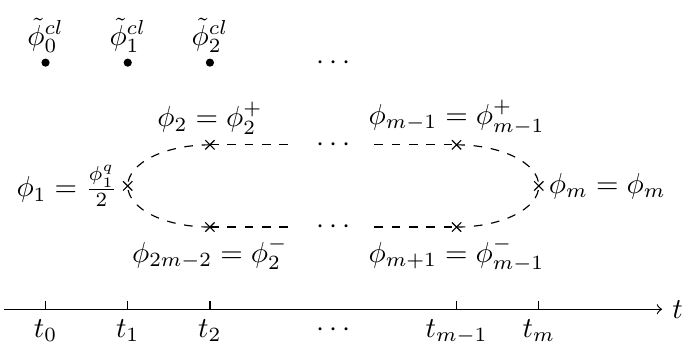
represents the solution n